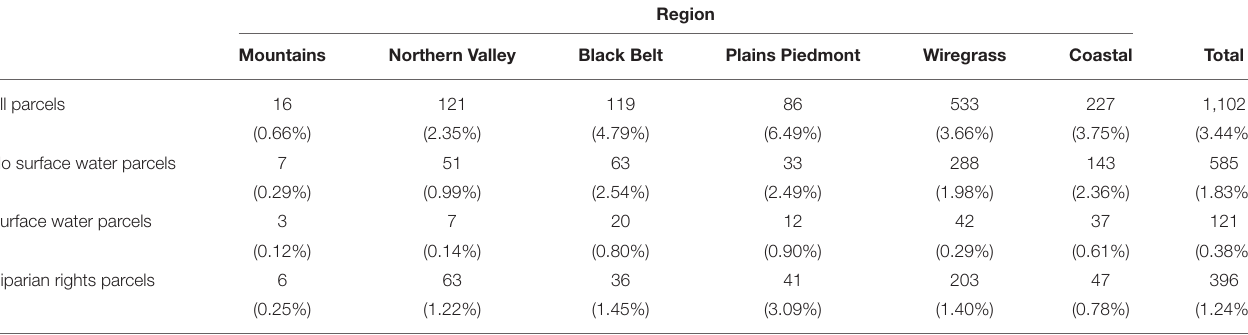
TABLE 4 | Number and percent of eligible parcels with new irrigation (i.e., adoption or expansion events) per water group (i.e., type of surface water access) and region.